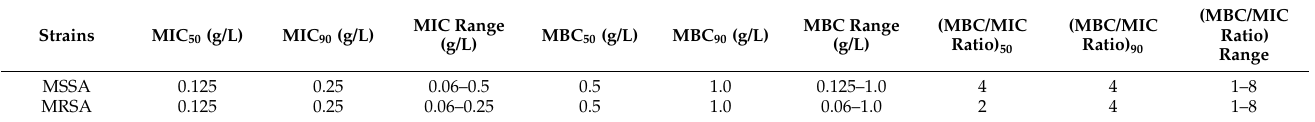
Table 1. Bactericidal activity of sodium bituminosulfonate against methicillin-susceptible